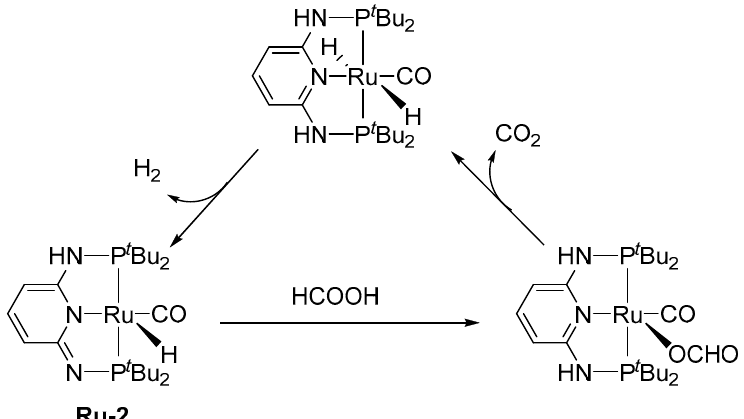
Figure 2. Proposed mechanism for FADH catalyzed by Ru-2 . Gonsalvi et al. developed an in-situ catalyst system for FADH, with a Ru complex ( Ru-3 ) in the presence of a linear tetraphos ligand, P4 (1,1,4,7,10,10-hexaphenyl-1,4,7,10- tetraphosphadecane) [15]. Among the two stereoisomers (Figure 3), the meso isomer was more effective for Ru catalysis than the rac -isomer. The authors investigated the catalyst durability in a long-term reaction, using a pump to feed an FA solution. [RuCl 2 (benzene)] 2 / meso -P4 (1/2) was employed (conditions: FA/DMOA (11:10) 5.0 mL, PC 1.0 mL at 60 °C), and the catalyst mixture was recyclable 11 times, with a total TON of 220 000 in 48 h. However, rac -P4 could be recycled for only eight consecutive runs when it was used as a ligand under similar reaction conditions, although the mixture showed catalytic activity. No CO was detected in the produced H 2 /CO 2 gas. This gas can be supplied directly to the H 2 /O 2 PEM fuel cell to generate electricity. The fuel cell could generate a stable current to drive the fan, owing to the continuous gas supply. Figure 3. Structures of rac- and meso -P4. Subsequently, Huang et al. developed a Ru complex ( Ru-4 ) with a bisimidazoline ligand for FADH in H 2 O because Li et al. demonstrated that the bisimidazoline ligand of an Ir complex was effective for FADH [16,32] . Although the catalytic activity of the Ru complex was lower than that of the Ir analog, a TOF of 12,000 h − 1 and TON of 350,000 were achieved with HCOONa at 90 °C. In addition, highly pressurized H 2 /CO 2 (24 MPa) was produced, without CO contamination. Recently, Milstein et al. obtained a high TON of more than 1.7 million and TOF of 3067 h − 1 , with Ru-5 bearing a 9H-acridine pincer ligand as the FADH catalyst at 95 °C [17] . The characteristic feature of this catalytic system is that it maintains catalytic activity for two months and has high durability in a neat solvent. Various iridium catalysts are also reported to be effective (Figure 4). In 2009, Himeda discovered that Cp* Ir catalysts with N^N-bidentate ligands, such as 2,2 ′ -bipyridine (BPy), catalyzed FADH [18] . This type of catalyst, which is water-soluble, is catalytically active toward aqueous FADH without organic bases, such as amine derivatives. Himeda et al. found that the electron-donating property of the ligand affected the improvement of catalytic performance. For example, Cp*Ir catalysts bearing 4,4 ′ -dihydroxy-bipyridine ( Ir- 1 ) showed 80-fold higher catalytic activity than the BPy catalyst for FADH. Next, when the OH group on the ligand was moved to the ortho position, interesting findings were obtained from the viewpoint of the reaction mechanism [19,33] . First, the pH dependence